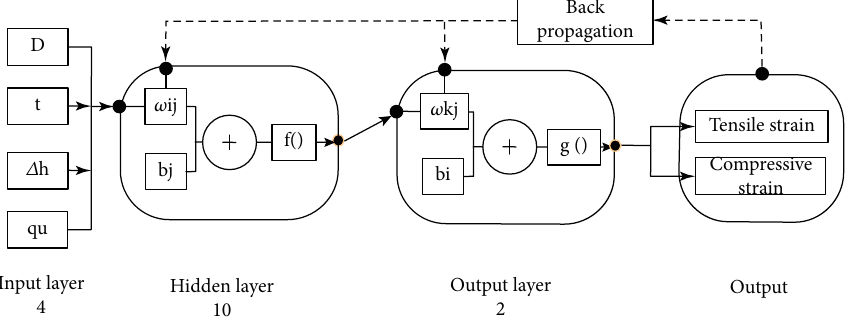
Figure 16: Structure of longitudinal strain prediction model for pipes subjected to frost heave displacement based on BPNN.